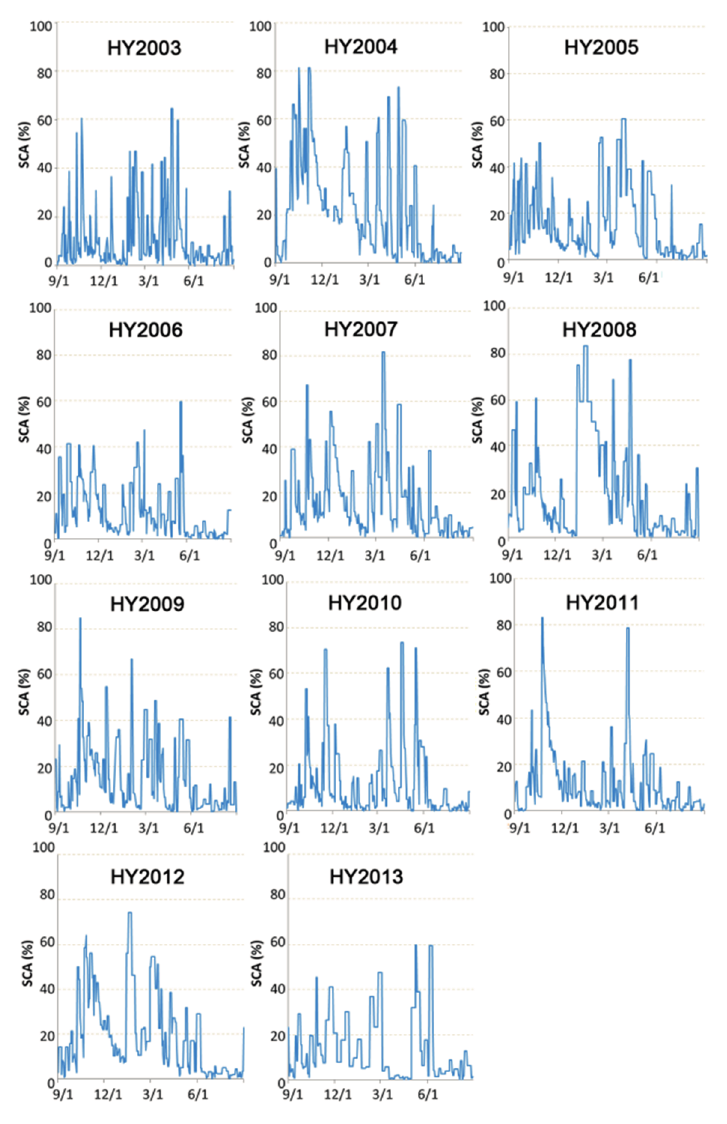
Figure 3. Time series of snow cover area (SCA) percentage (%) over the basin area from flexible multiday combined MODIS images, in the Upper Heihe River Basin during